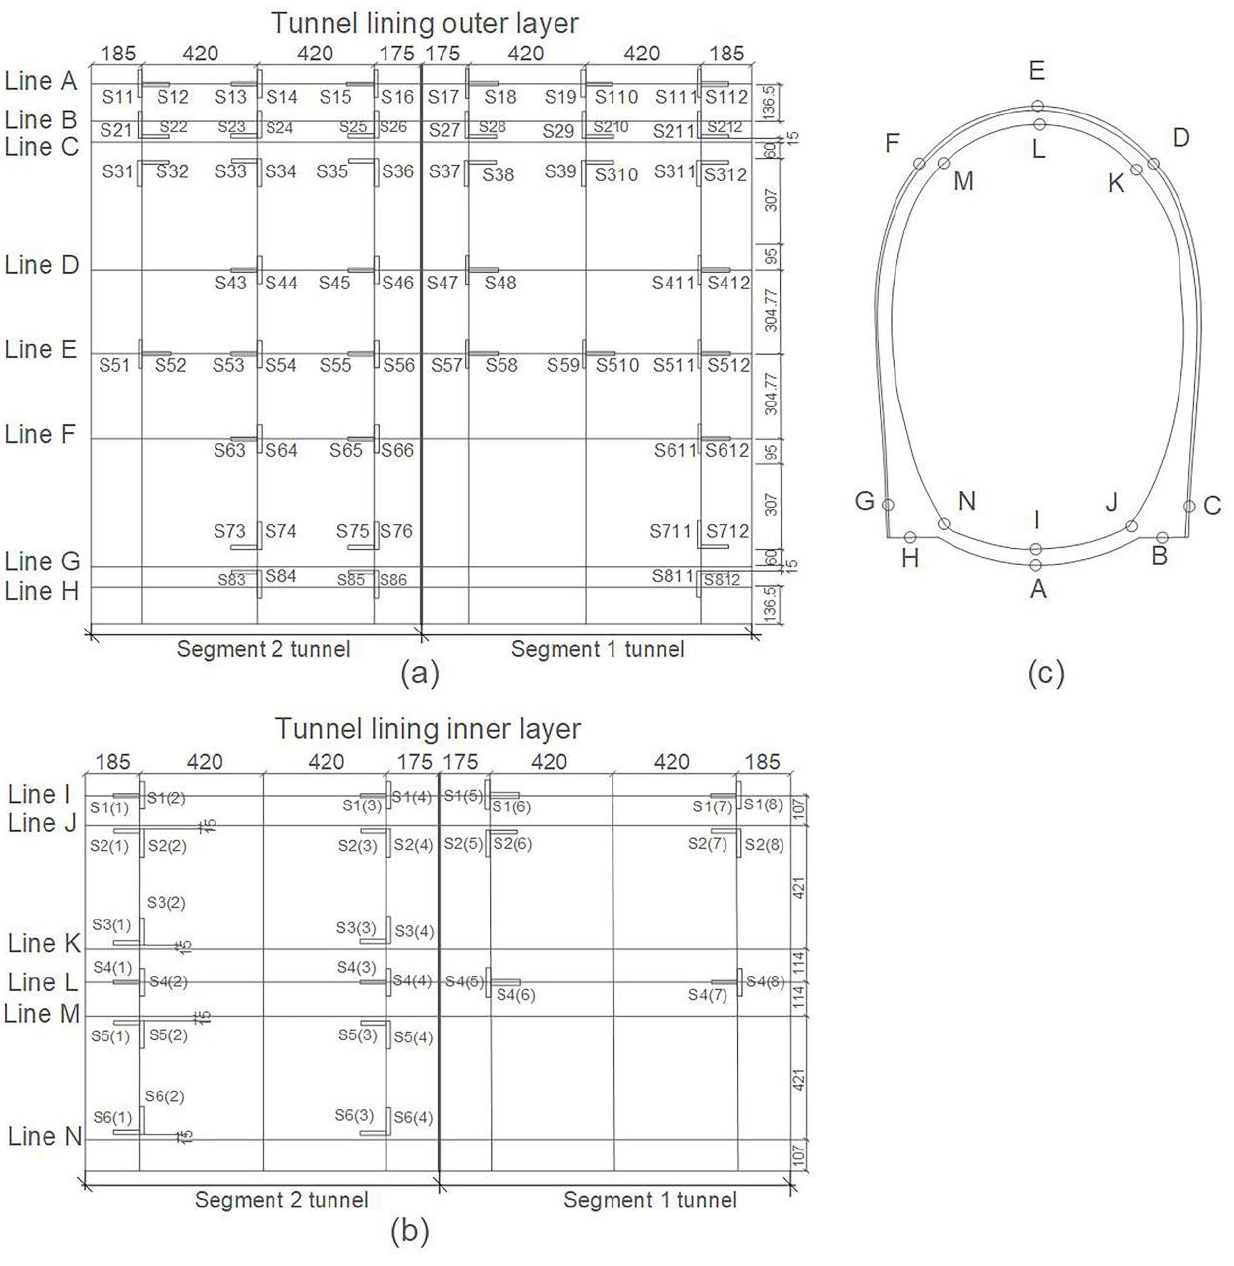
Figure 3. Layout of strain gauges. Combination marks of letter S and numbers are strain gauge numbers. A total of 112 strain gauges were deployed on the inner and outer tunnel lining. The data units in the figure are mm. ( a ) Tunnel outer lining; ( b ) tunnel inner lining; ( c ) tunnel cross section.